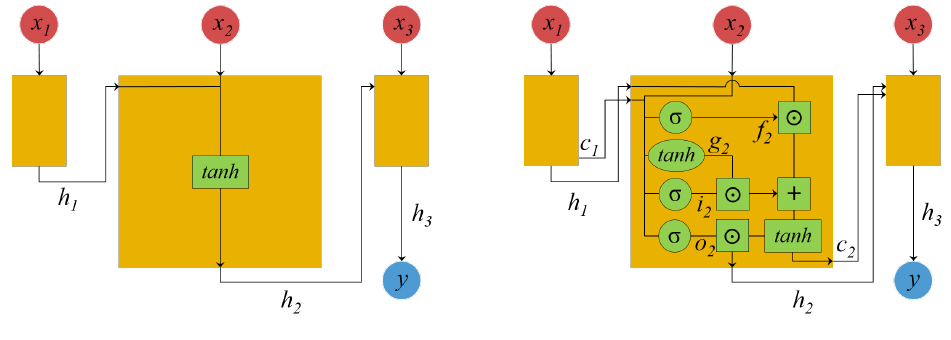
Figure 6. Recurrent neural network (RNN) model ( left ) and long short-term memory (LSTM) model ( right